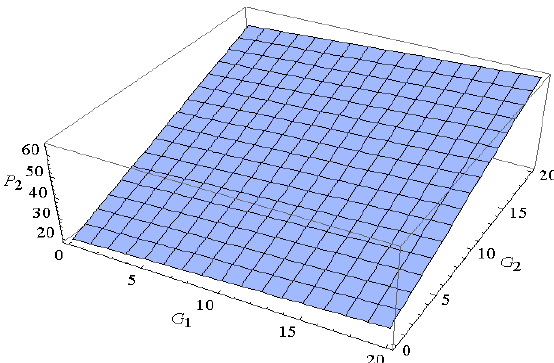
Figure 3. The impact of competitive product goodwill on the retail price of Product 1.